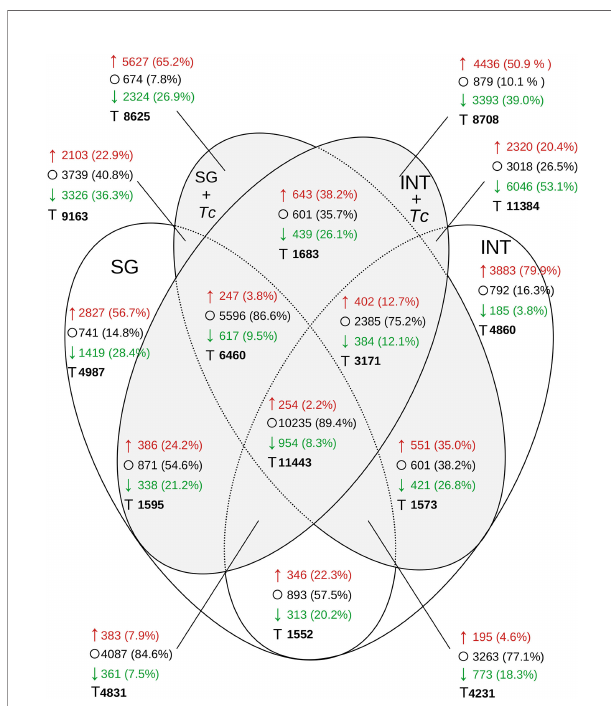
FIGURE 10 | Distribution of R. neglectus transcripts per expression level on day 2, after feeding compared to the prolonged fasting. Transcriptional expression comparison in SGs and INT of R. neglectus , according to the presence of infection by T. cruzi , after hematophagy. * ↑ , 2 times upregulated; ○ , Not changed; ↓ , 2 times downregulated; T, Total. SG, Salivary Gland; I, Intestine; Tc, T. cruzi